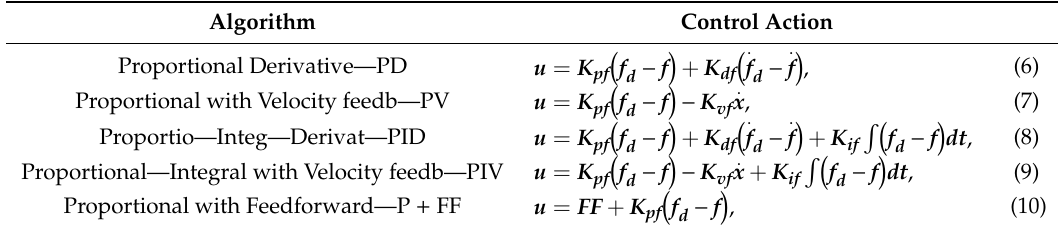
Table 1. Typical control action for outer force